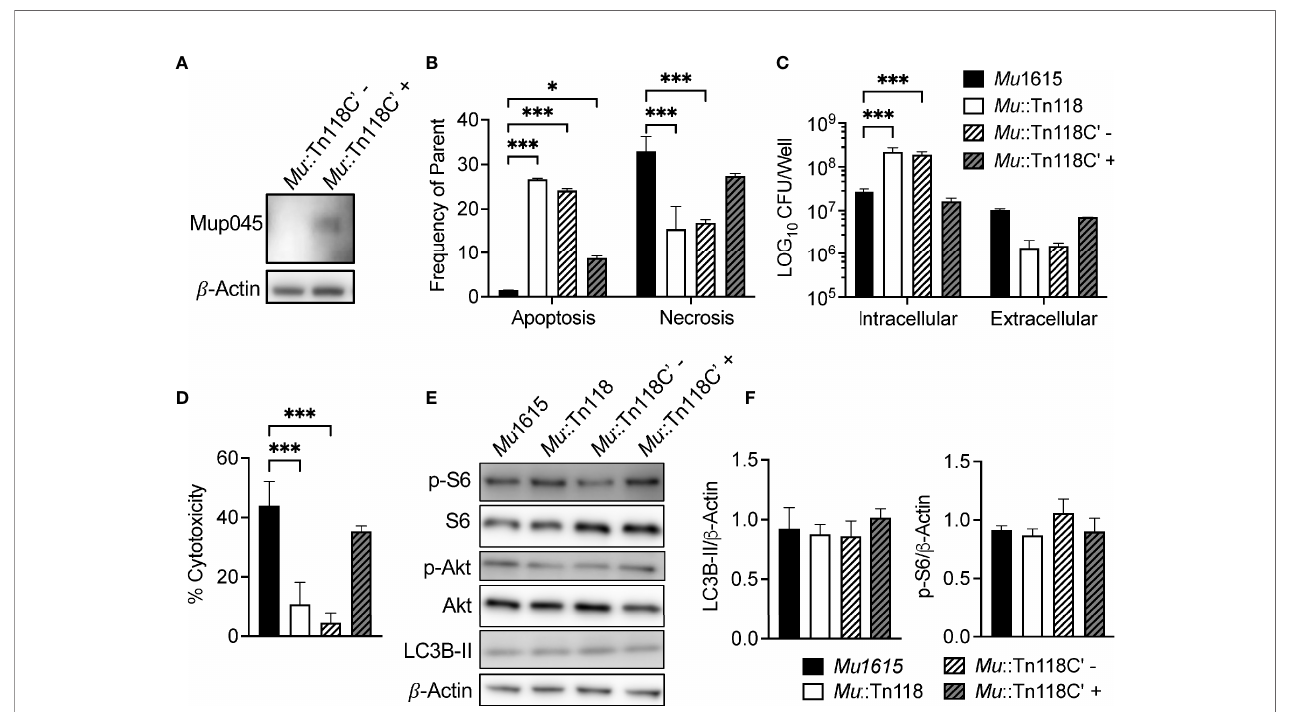
FIGURE 5 | Induced synthesis of mycolactone restores Mu ::Tn118 necrosis allowing for bacterial escape from macrophages. (A) Representative immunoblot for HA-tagged mup045 from THP-1 monocyte-derived macrophages infected with Mu::Tn118C ’ ± 1 m g/ml aTCN at MOI 10, 72 h postinfection. A representative experiment from three independent experiments is shown. (B) Apoptosis and necrosis were assayed by staining with Annexin-V and 7-AAD in THP-1 monocyte- derived macrophages infected with Mu 1615, Mu ::Tn118 or Mu::Tn118C ’ ± 1 m g/ml aTCN at MOI 10, 72 h postinfection. (C) THP-1 monocyte-derived macrophage lysates and culture supernatants were plated for CFU enumeration at 72 h postinfection with Mu 1615, Mu ::Tn118 or Mu::Tn118C ’ ± 1 m g/ml aTCN at MOI 10. (D) THP-1 monocyte-derived macrophages infected with Mu 1615, Mu ::Tn118, or Mu ::Tn118C ′ at MOI 10, and culture supernatants were measured for LDH release at 72 h postinfection. (E) Immunoblots were assayed from lysates of THP-1 monocyte-derived macrophages infected with Mu 1615, Mu ::Tn118 or Mu::Tn118C ’ ± 1 m g/ml aTCN at MOI 10, 72 h postinfection for LC3B-II, p-Akt, total Akt, phosphor-S6, or total S6. (F) Summary densitometric analysis was calculated by LC3B-II or p-S6 normalized to b -actin. All graphs represent one of two independent experiments with data expressed as mean ± SD. Signi fi cance was calculated by two-way (B, C, F) or one-way (D) ANOVA corrected by Bonferroni or Dunnett ’ s test for multiple comparisons. *p ≤ 0.05, *** ≤ p